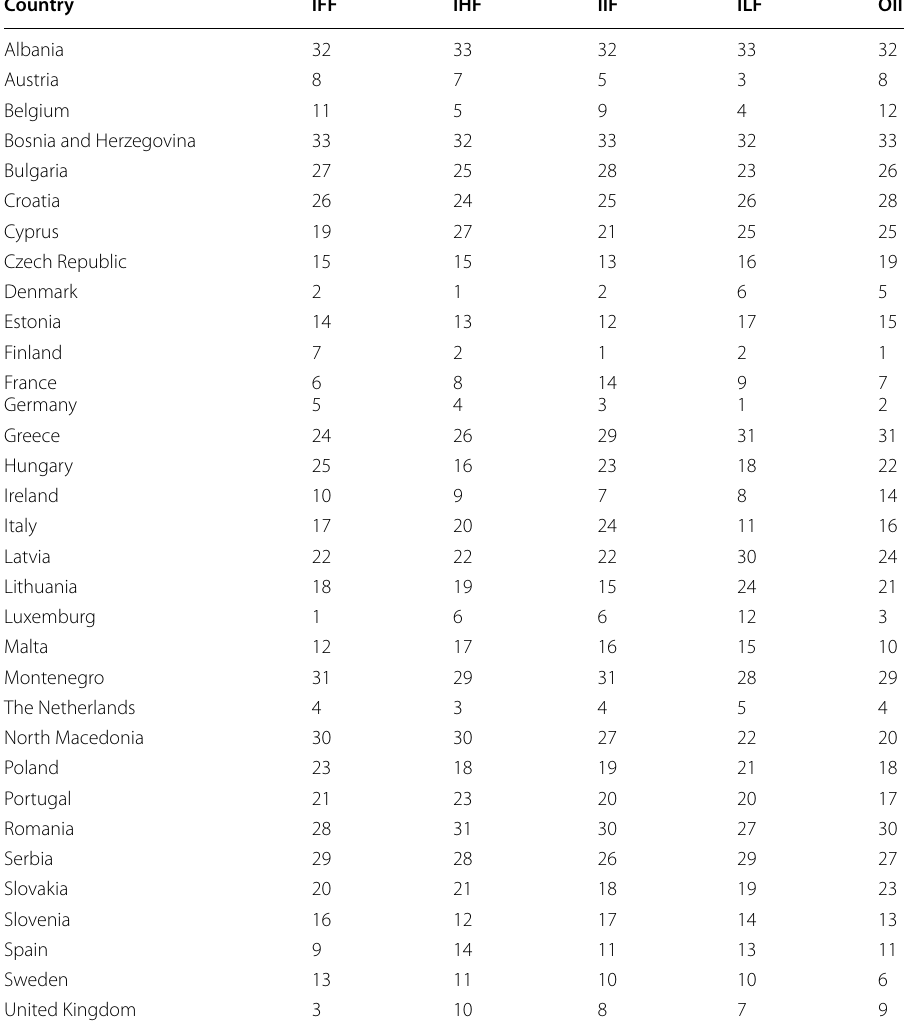
Table 8 Rankings of UIC input and output indicators over the period of three years (2015–2018) Country